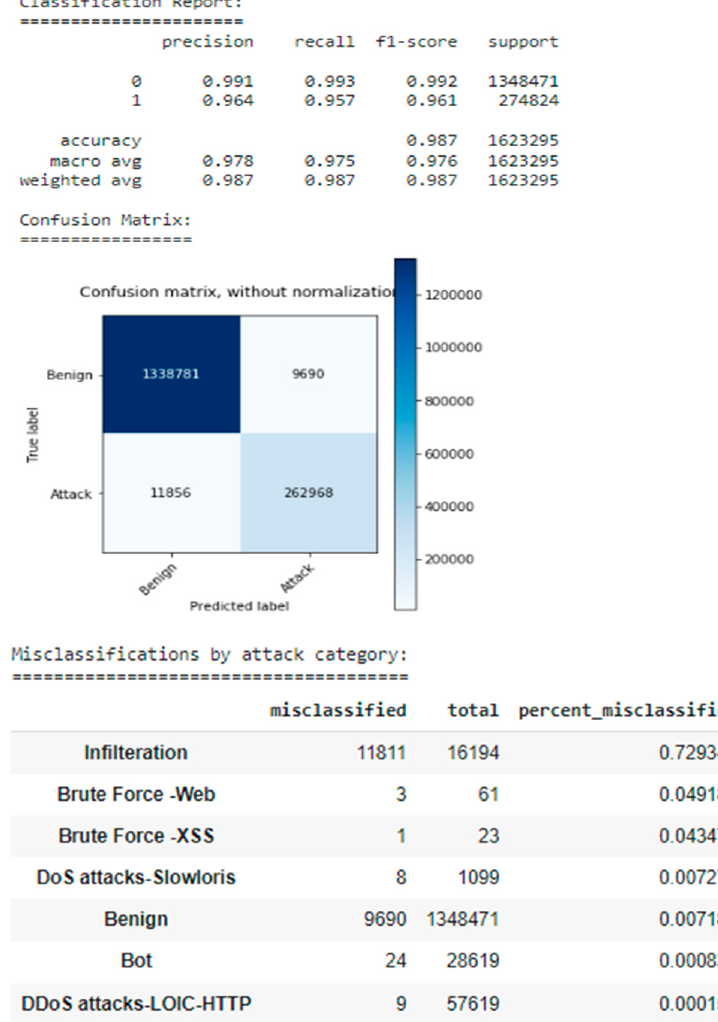
Figure 18. Performance on Test Set.